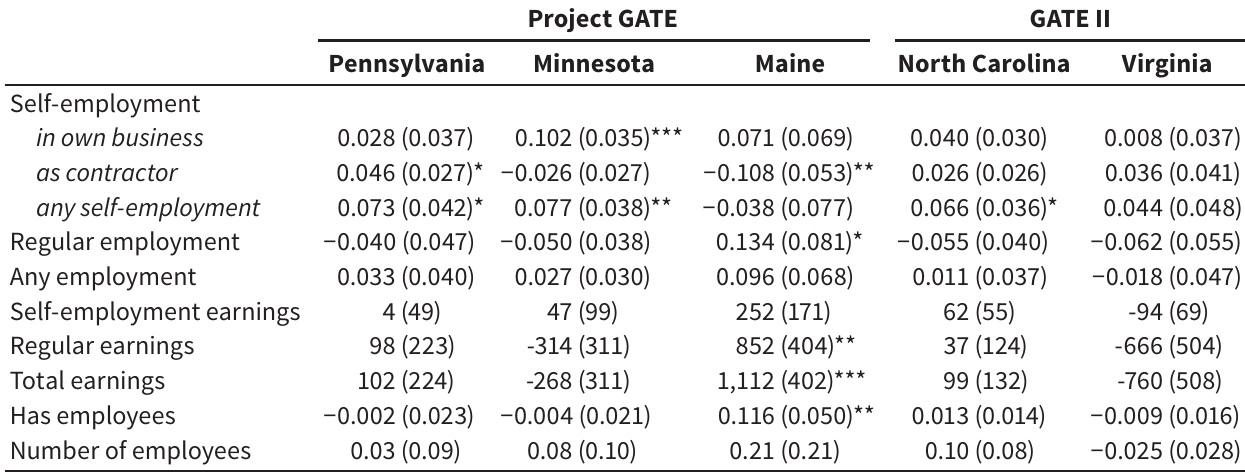
Intent-to-Treat (ITT) effects on employment and earnings